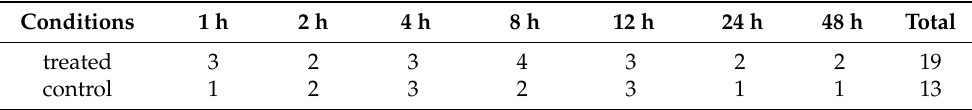
Table 1. The number of samples with the gene expression profiles. Treated means contact with the collagen–glycosaminoglycan